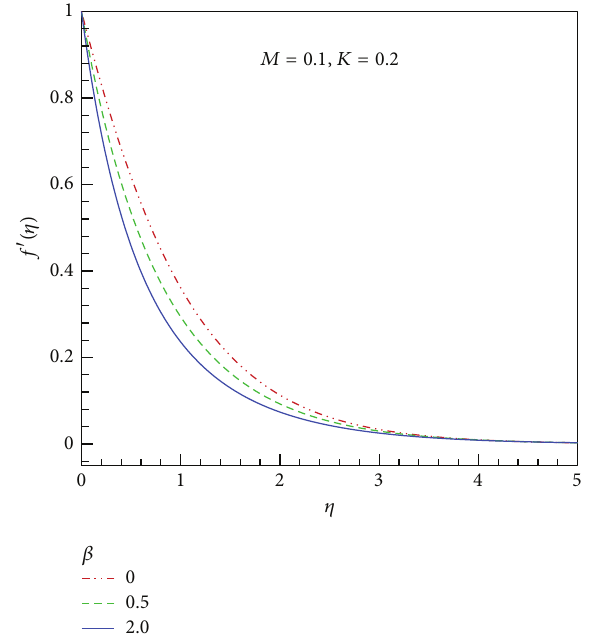
Figure 3: Effect of 𝛽 parameter on dimensionless velocity for 𝐾 = 0.2 , 𝑀 = 0.1